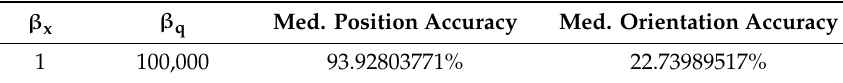
Table 5. Accuracy of the exponential-based